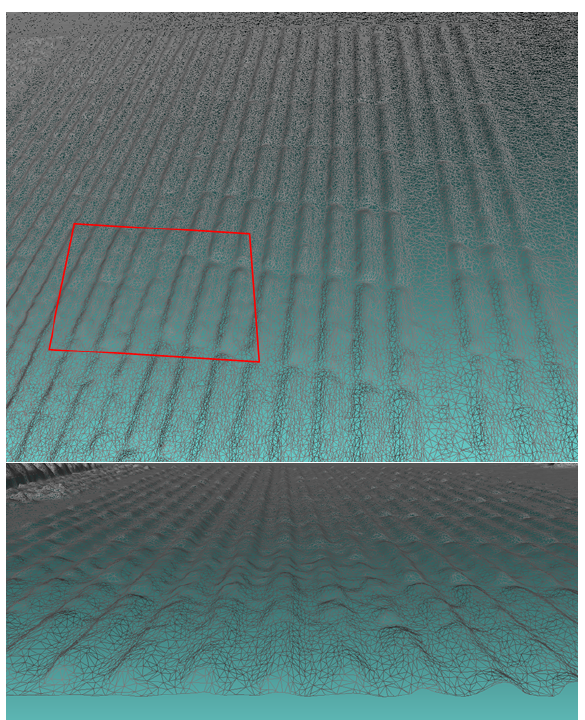
Figure 6. The DSM model extracted from the COSI images seen from two different perspectives. Area shown in Figure 5 marked in